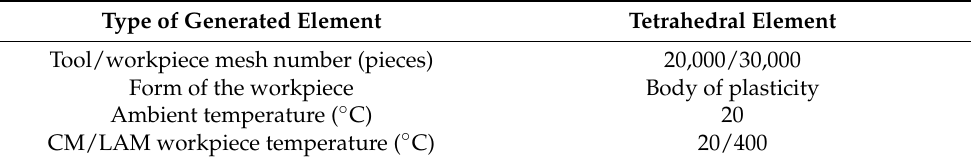
Table 2. Model data.